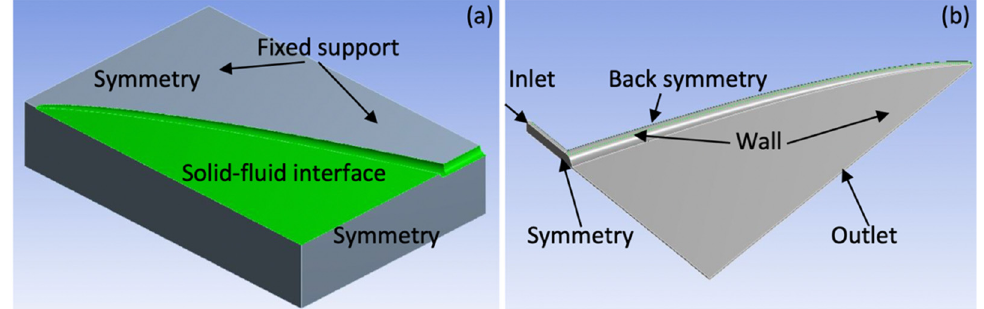
Figure 3. ( a ) Solid domain and ( b ) fluid domain.